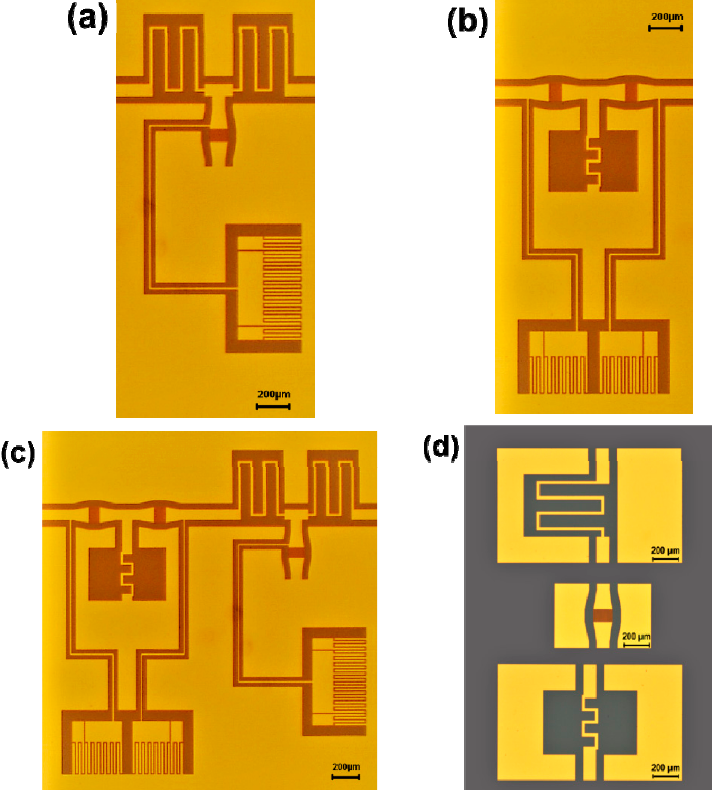
Figure 3. Optical pictures of the ( a ) low-pass filter, ( b ) high-pass filter, and ( c ) band-pass filter; and, ( d ) optical picture of the test structures. From top to down: inductor for low-pass filter, interdigital capacitor and inductor for high-pass filter.